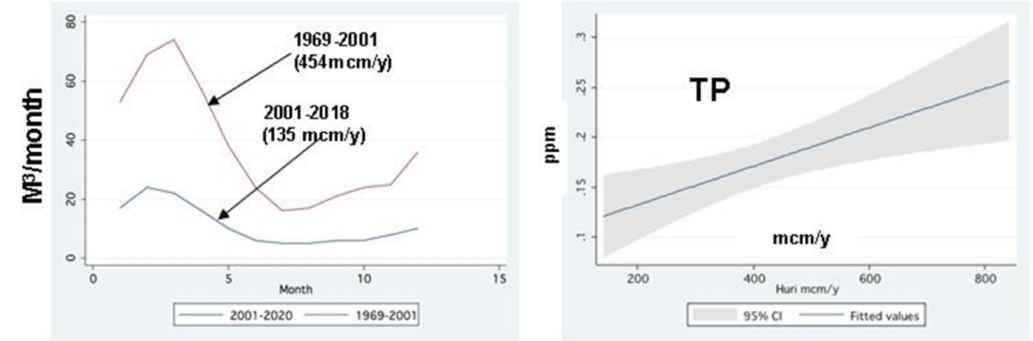
Figure 3. Right : linear regression (95% CI) between the River Jordan discharge (10 6 m 3 /year) and the concentration (ppm) of total phosphorus (TP) in Jordan waters. Left : line scatter plot of the monthly discharge of River Jordan, averaged for two periods: 1969–2001 and